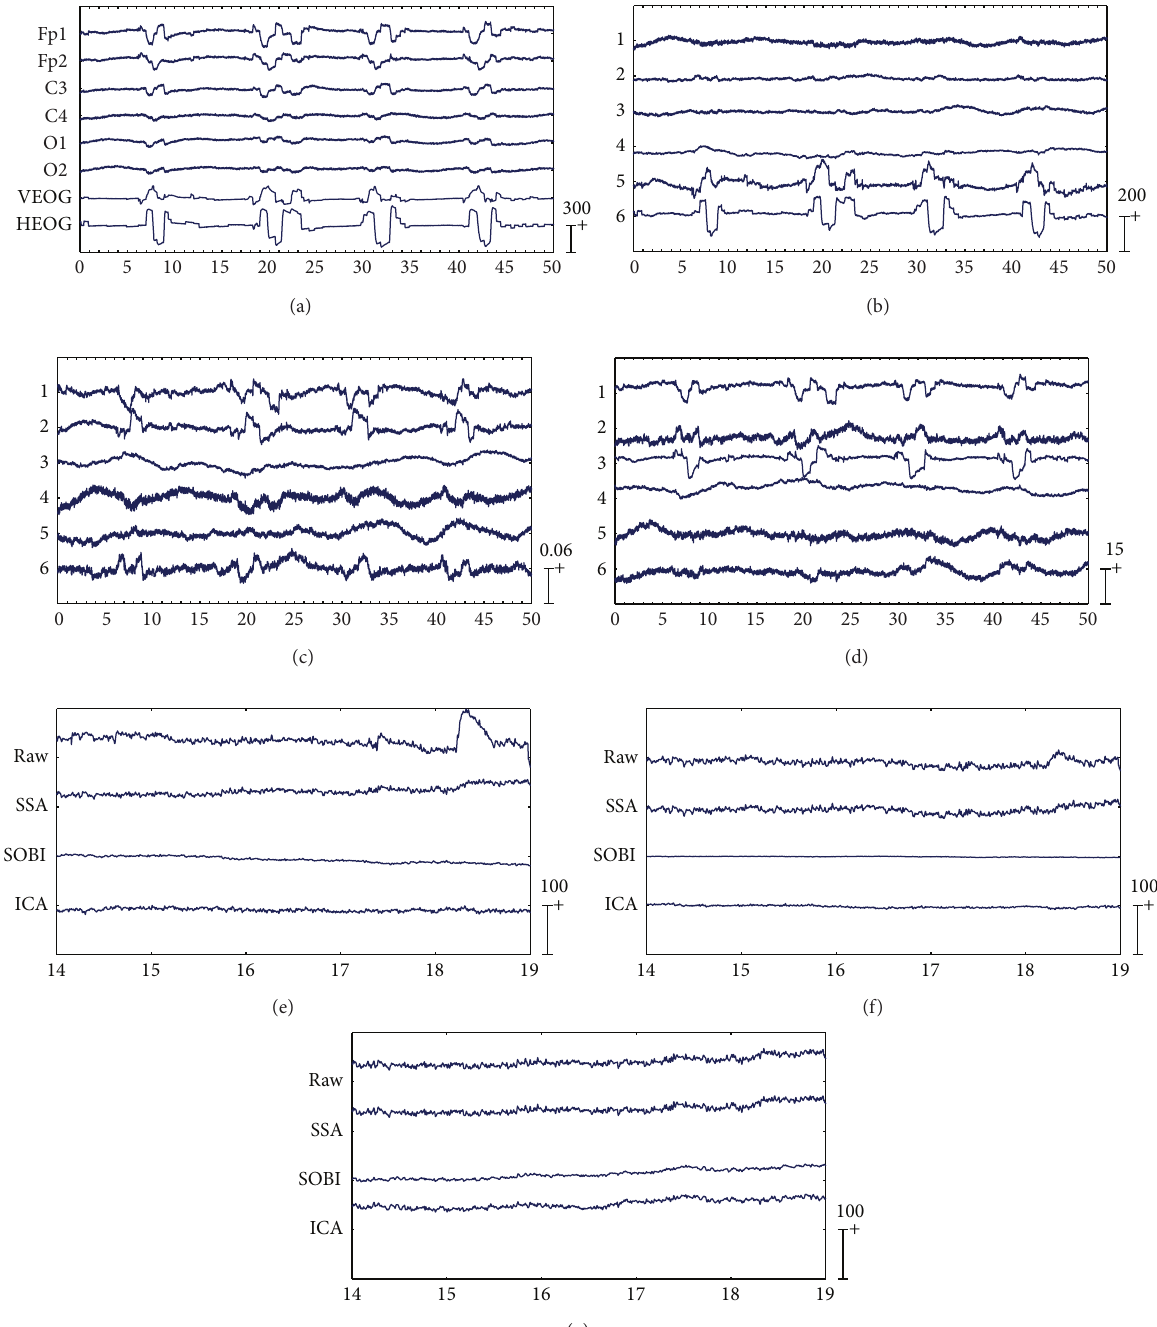
Figure 5: Results of EOG artifact removal on an example EEG data set from the 20 real recordings. The EEG data with eye movement artifacts are shown in the first six EEG channels of (a) and the corresponding EOG signals are presented in the last two channels of (a). Components separated by SSA, SOBI, and ICA are shown in (b), (c), and (d), respectively. The zoomed raw and corrected EEG signals by each method on channel Fp1, C3, and O1 are depicted in (e), (f), and (g), respectively.